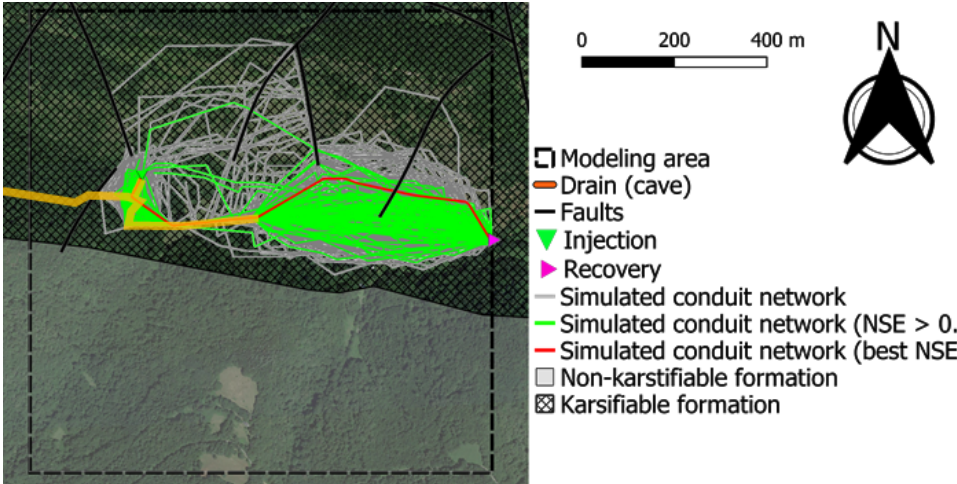
Figure 7. 2D representation of the simulated tracer pathways, extracted from the synthetic conduit networks simulated with SKS.